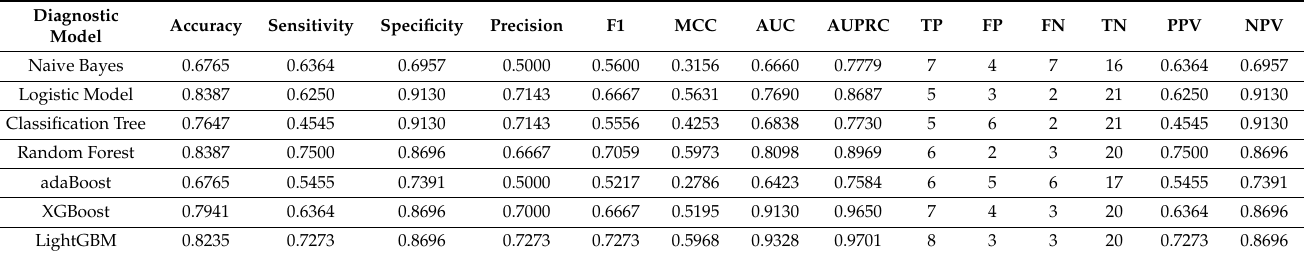
Table 2. Performance of the prediction models generated by seven machine learning algorithms. F1: F1 score; MCC: Matthews correlation coefficient; AUC: area under curve; AUPRC: area under the precision-recall curve; TP: true positive; FP: false positive; FN: false negative; TN: true negative; PPV: